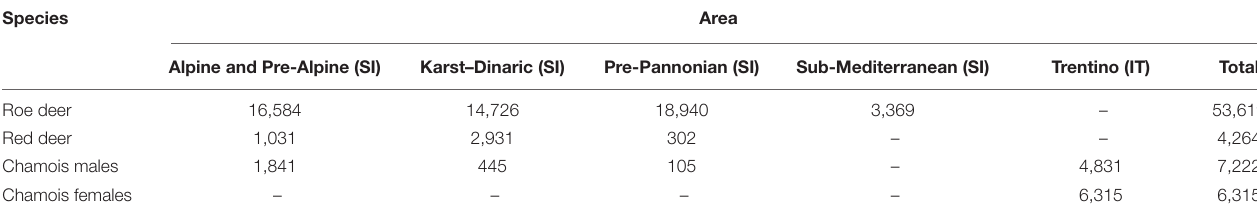
TABLE 1 | Sample size (n) subdivided by species and